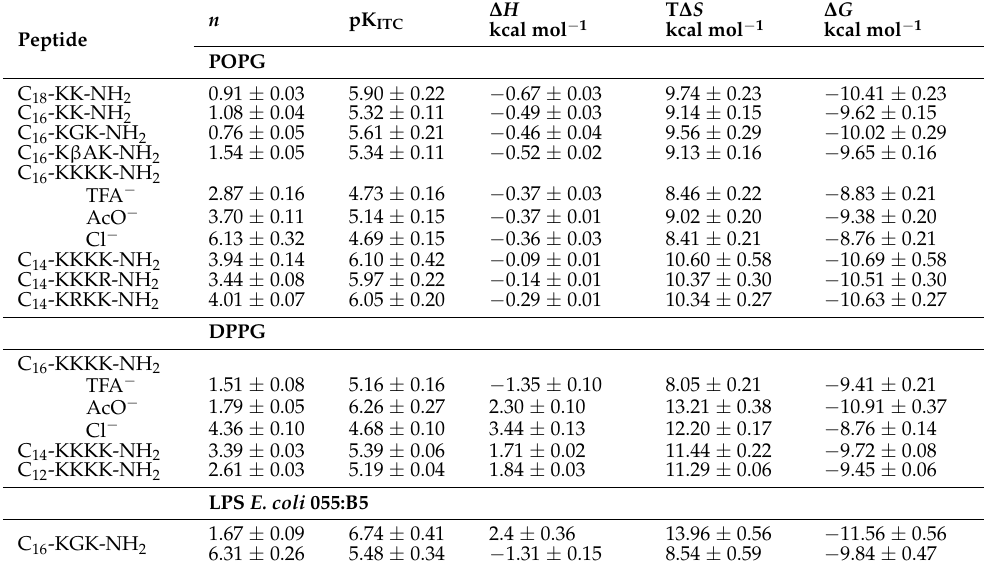
Table 3. Thermodynamic parameters for the binding of the lipopeptides to POPG and DPPG LUVs (large unilamellar vesicles) and LPS E. coli